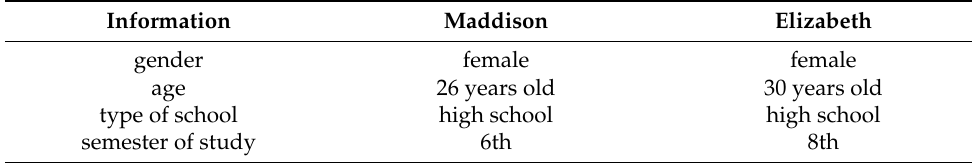
Table 1. General information about Maddison and Elizabeth.